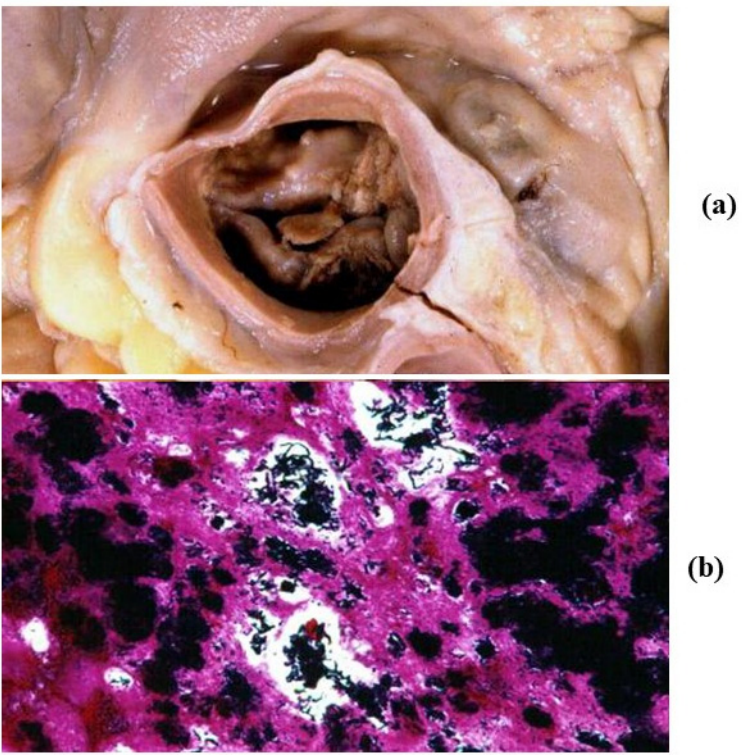
Figure 7. Infective endocarditis ( a ) with cocci ( b ) in a young drug addict with bicuspid aortic valve. (Gram stain). (Gram